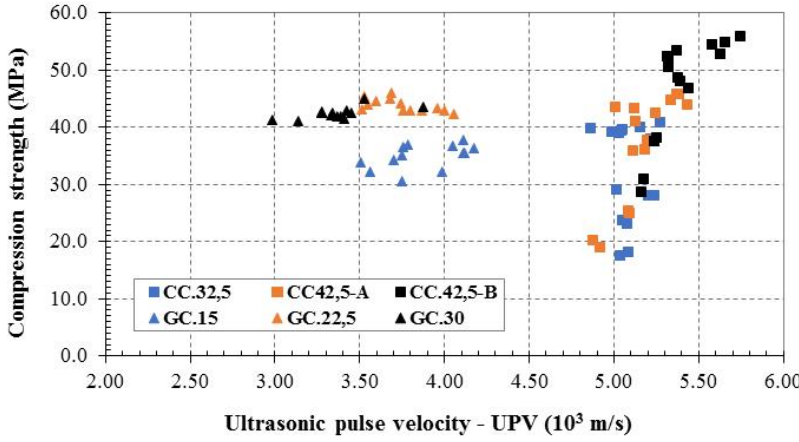
Figure 10. Correlation between UPV and compressive strength of concretes.